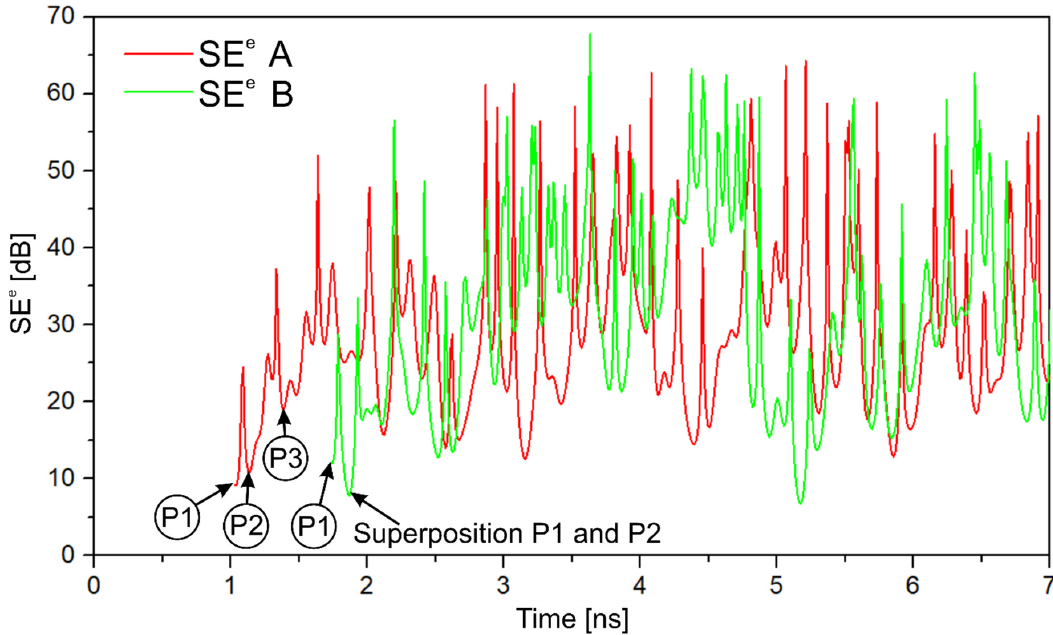
Figure 10. Time-dependence of the shielding effectiveness SE e of the electric field at points A (0, 0, 0) and B (0, 0, − 211.5) over 0–7 ns—the local SE e at points A and B. The SE e labeled P1, P2, and P3 (in circles) correspond to the passages of the primary waves P1, P2, and P3 through points A and B. The SE e labeled “Superposition P1 and P2” corresponds to the constructive interference of the primary waves P1 and P2 moving in opposite directions to each other.